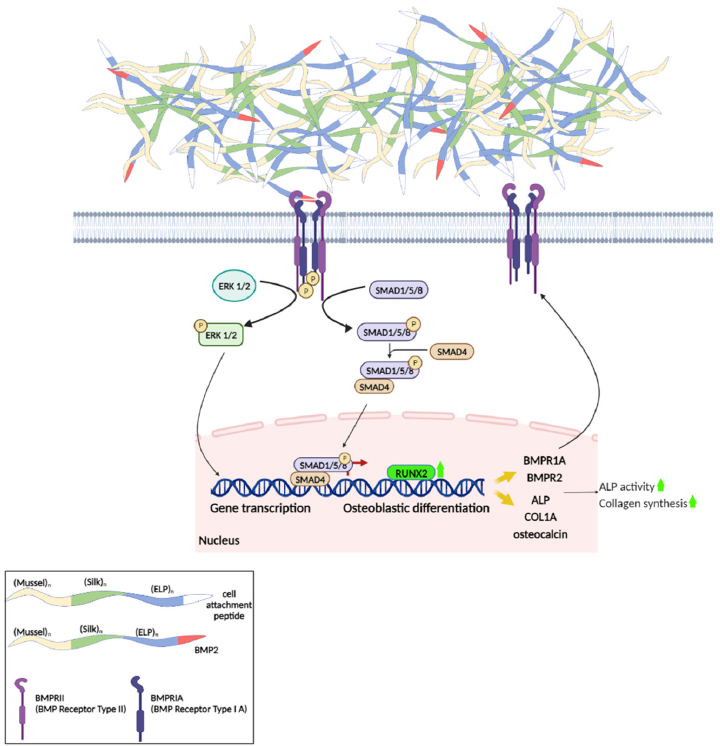
Scheme 2. Schematic representation of the signal transduction induced by the scaffold-BMP2 in hu- man dental pulp stem/stromal cells. Upon binding of the drastic BMP-2 peptide to the BMR1A/BMPR2 receptor complexes, the activated BMPR1A receptor (a serine–threonine kinase) phosphorylates and activates intracellular Smads-1/5/8 and Erk-1/2 . Activated Smad-1/5/8 forms a